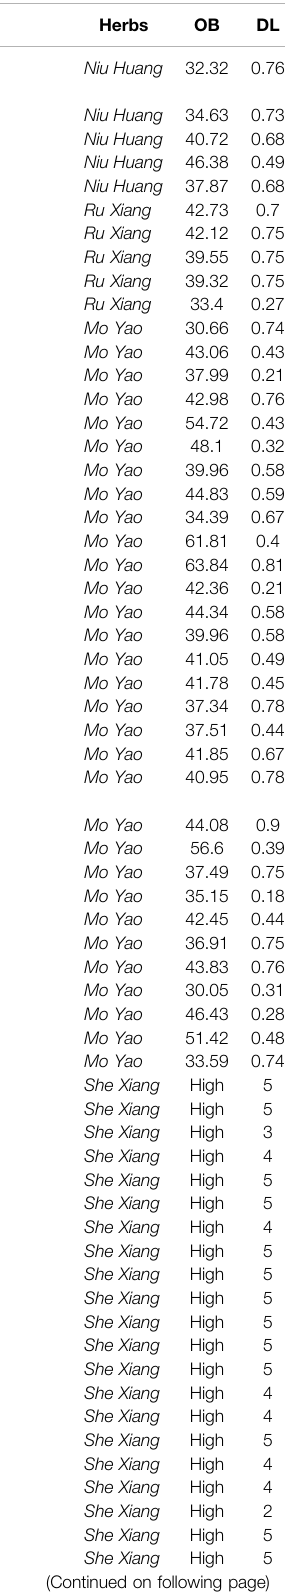
TABLE 1 | The active compounds in Xihuang